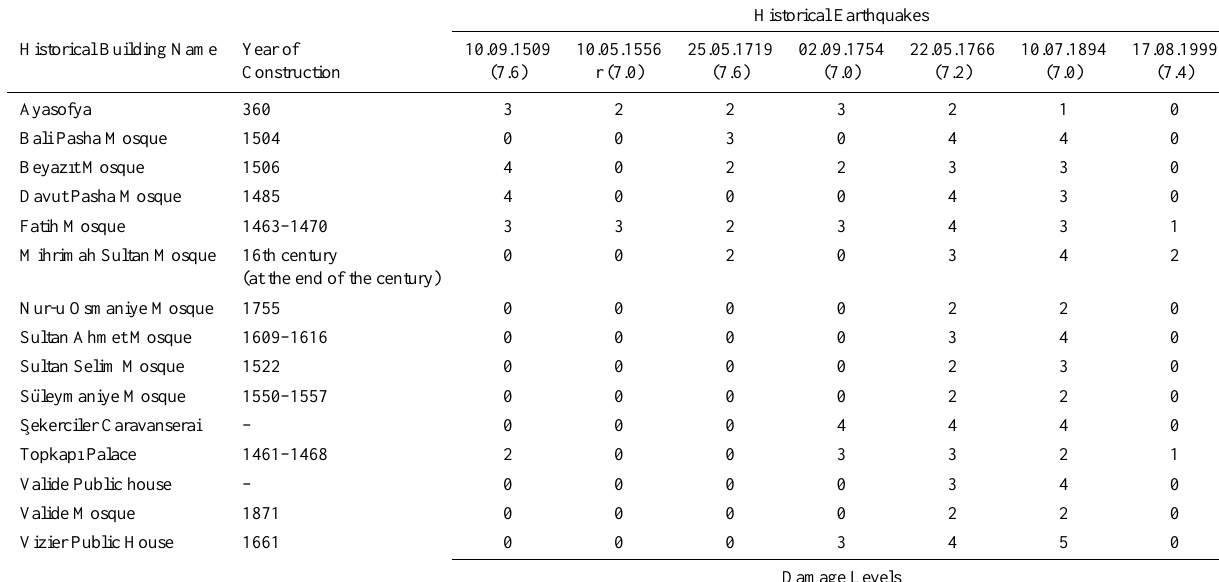
Table 7. The construction dates of the historical structures in Old Istanbul (Fatih-Emin¨on¨u districts) and their damage levels during several earthquakes (Erdik et al., 2001).